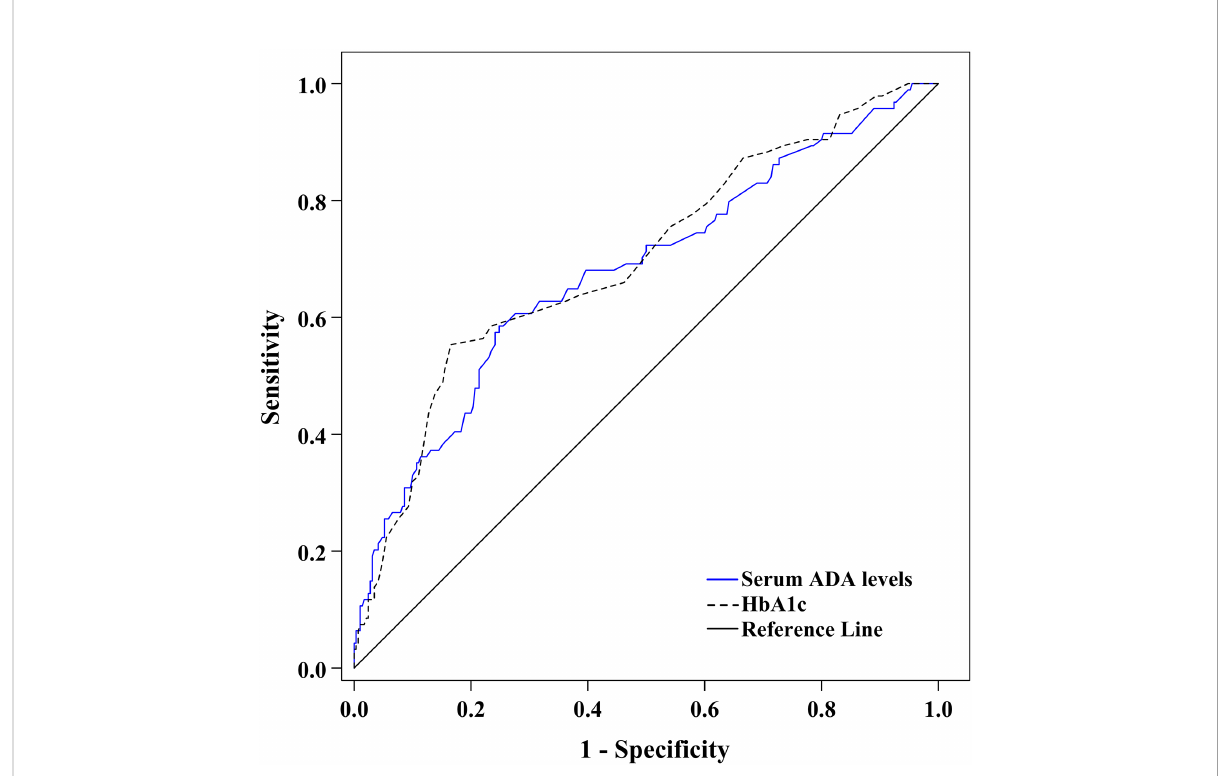
FIGURE 5 ROC curve comparing the capability of serum ADA levels with HbA1c to discriminate